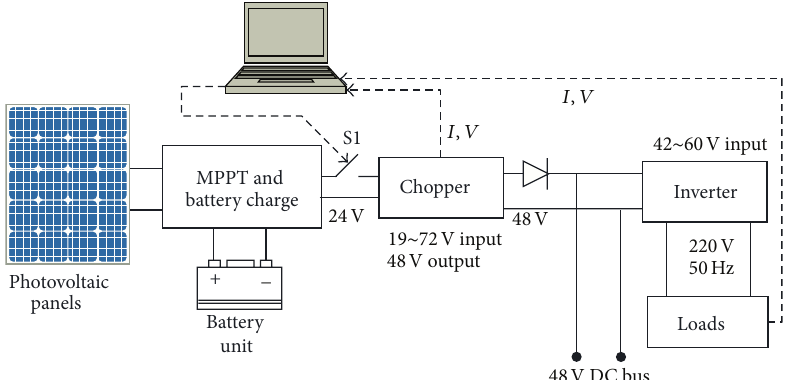
Figure 2: The PV power generation part of the system.